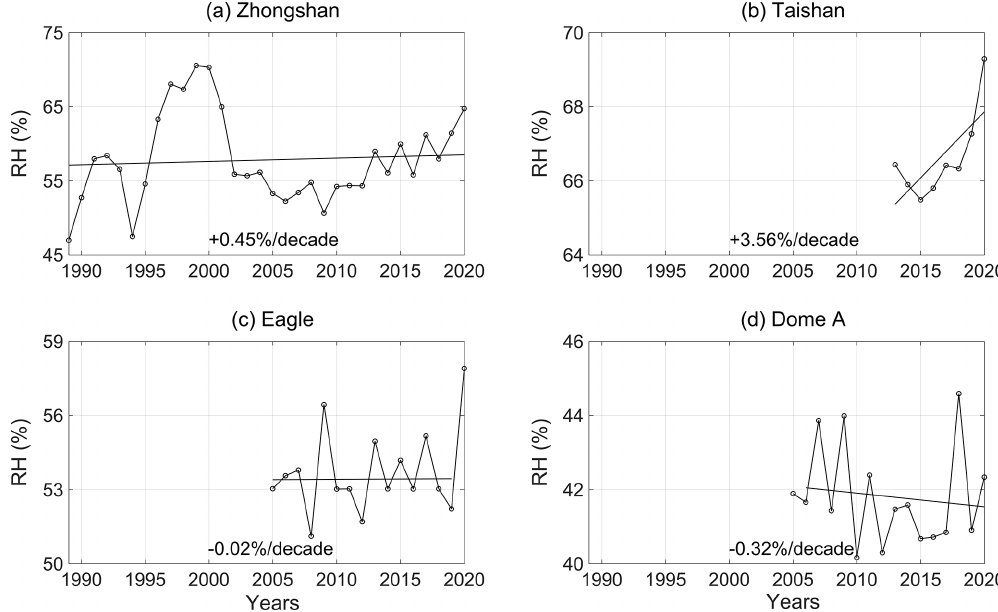
Figure 7. Interannual variation in relatively humidity at Zhongshan ( p < 0.05), Taishan ( p < 0.05), Eagle and Dome A.